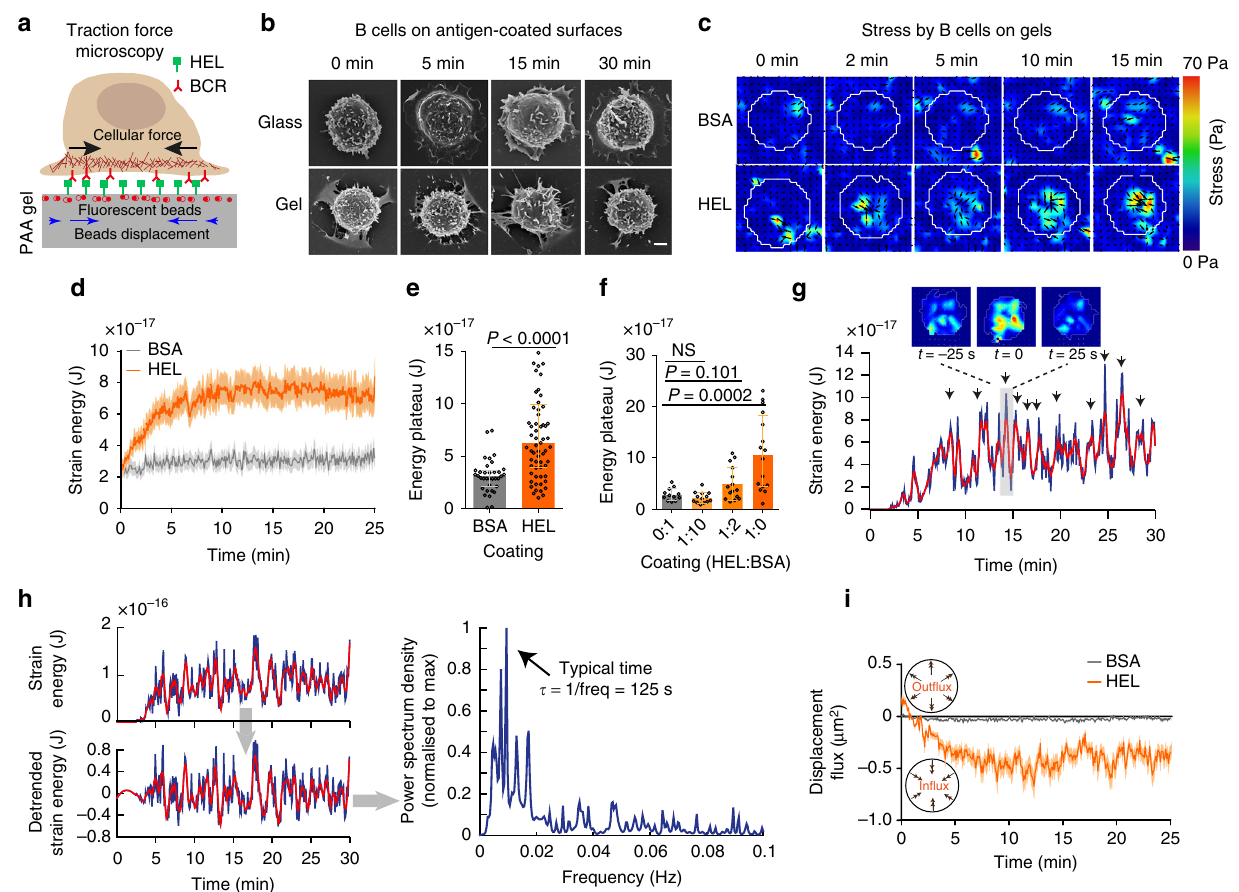
Fig. 1 B cells show antigen-speci fi c pulsatile traction forces on PAA gels. a Cartoon of traction force microscopy showing B-cell plated on antigen-coated polyacrylamide (PAA) gel containing fi ducial markers. b Scanning electron microscopy of fi xed B lymphocytes on HEL-coated glass and PAA gels, scale bar is 2 µ m. c Time-lapse color maps of stress for HEL and control BSA condition; contractile stress can reach 70 Pa. d Comparison of average strain energy pro fi le for HEL and BSA conditions, error bars represent mean ± SEM ( n = 65 for HEL and n = 35 for BSA, fi ve independent experiments, fi ve mice), acquisitions were started before the arrivals of the cells to capture the initial time of contact and all cells were aligned at time zero. e Summary statistics of plateau of strain energy for HEL and BSA, error bar represents median ± IQR ( n = 65 for HEL and n = 35 for BSA, fi ve independent experiments, fi ve mice), Mann – Whitney test was performed for statistical analysis. f Concentration-dependent increase in strain energy, error bars representing median± IQR ( n = 12, 13, 15, 16, 3 independent experiments, three mice), Mann – Whitney test was performed for statistical analysis. g Example of the strain energy curve for a single cell, plateau exhibit isolated peaks (see single stress maps). h Extraction of the typical pulsation frequency from the contractile energy: from the time series of a coordinated energy signal (smoothed in red), the signal is de-trended and the power spectrum density derived from it shows a maximum, hence a typical time scale for the pulsation. i Displacement fl ux showing the direction of displacement over time in HEL and BSA condition (mean ± SEM, n = 65 for HEL and n = 35 for BSA, fi ve independent experiments, fi ve mice). Source data are provided as a Source Data fi